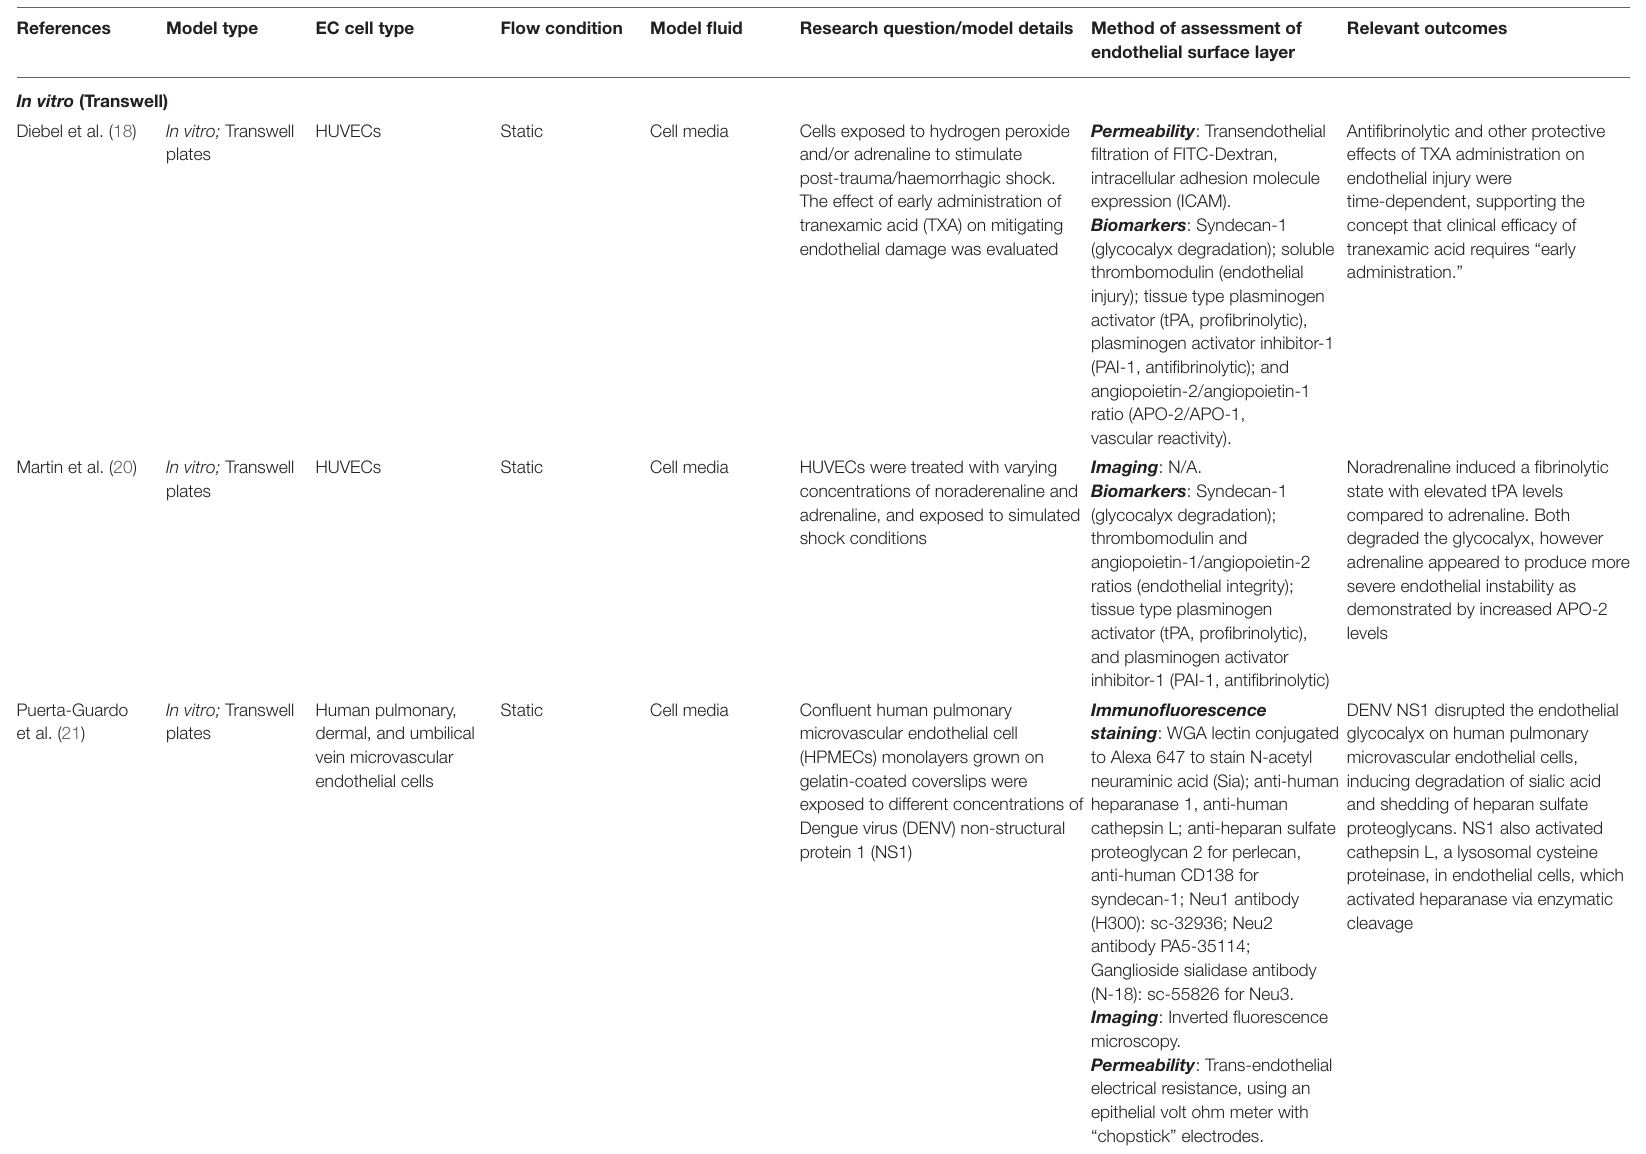
TABLE 1 | Summary of in vitro models that directly study glycocalyx